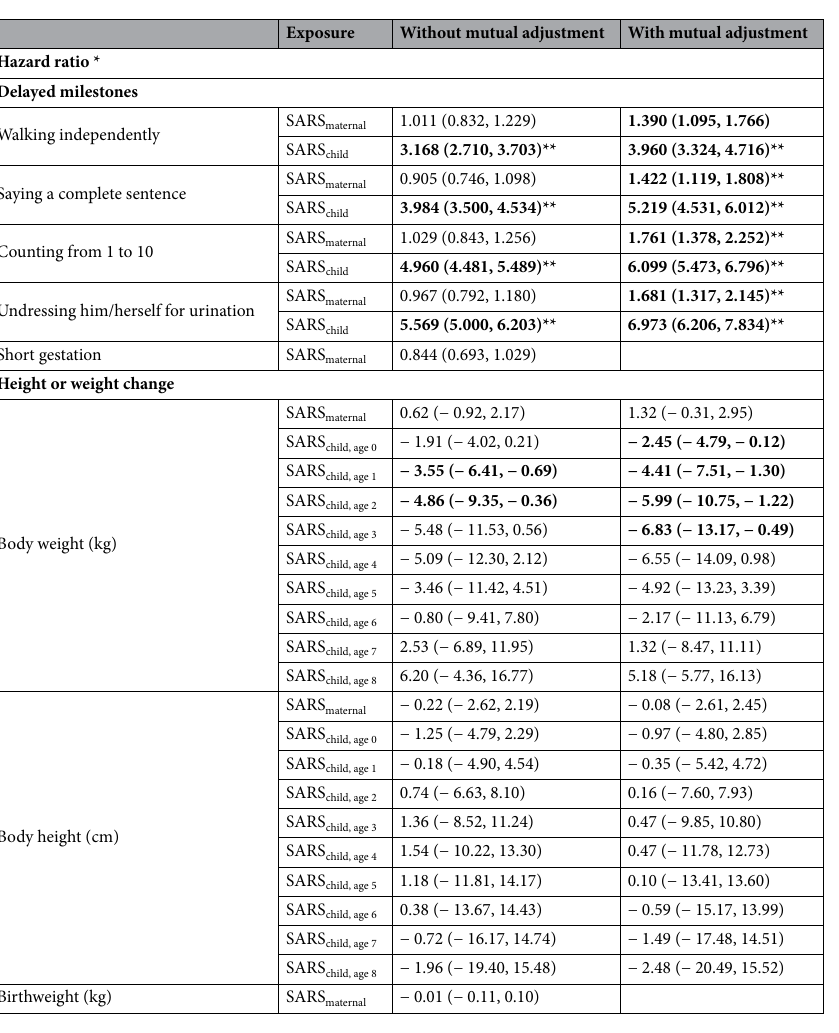
Table 2. Associations between SARS and indicators of child health. The bolded estimates denote statistically significant associations before Bonferroni correction. *The models were adjusted for sex, ethnicity, residence, gestational age, birthweight, breastfeeding duration, temporal trend and spatial random effect. **The estimated association between pandemic exposure and the delayed milestone was statistically significant after Bonferroni correction.